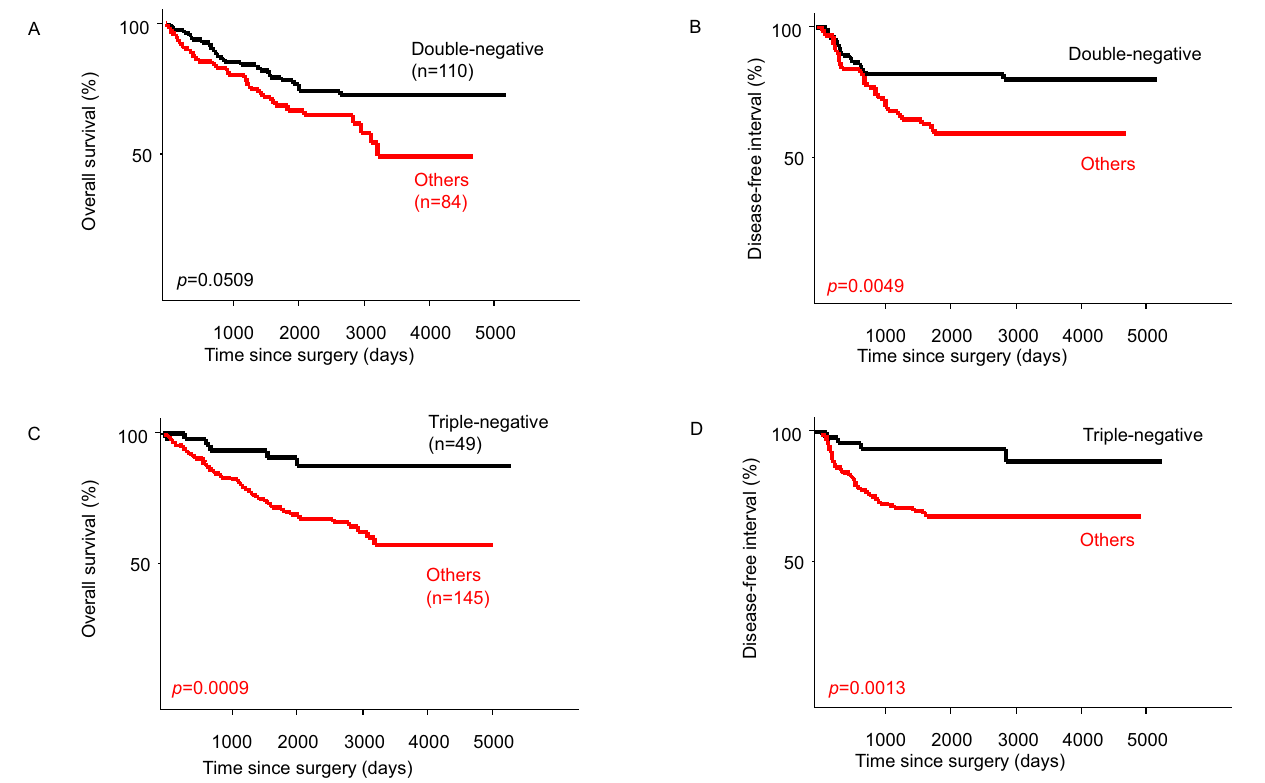
Figure 3. Kaplan–Meier curves of overall survival (OS) and disease-free interval (DFI) of the double-negative (ALDH1A1-negative + CD133-negative) and triple- negative groups (CSC marker-negative + mutant p53- negative). ( A ) OS curves stratified by the double-negative group or others. ( B ) DFI curves stratified by the double-negative group or others. ( C ) OS curves stratified by the triple-negative group or others. ( D ) DFI curves stratified by the triple-negative group or